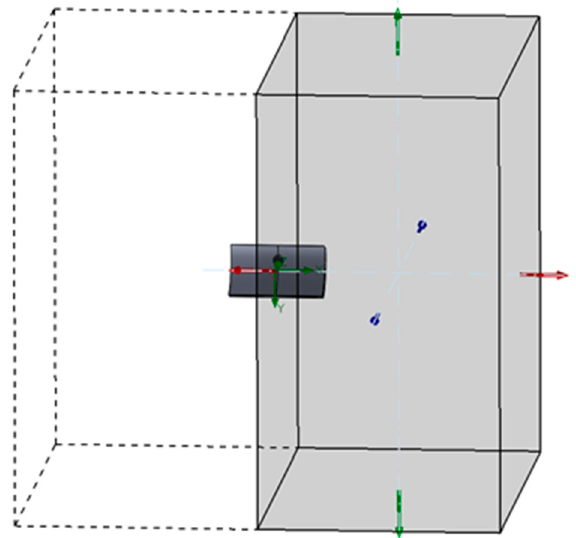
Figure 12. Shield geometry and fluid domain.